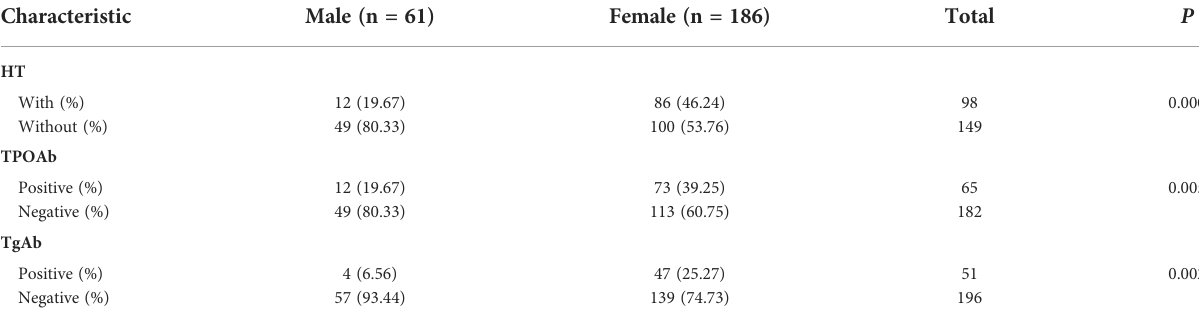
TABLE 2 HT prevalence and its autoantibodies in patients with OLP. Characteristic